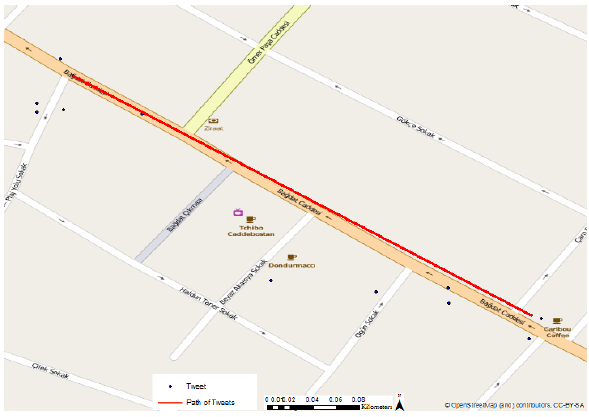
Figure 9. Pedestrian Travel Length within a Short Time routes like in Figure 10.